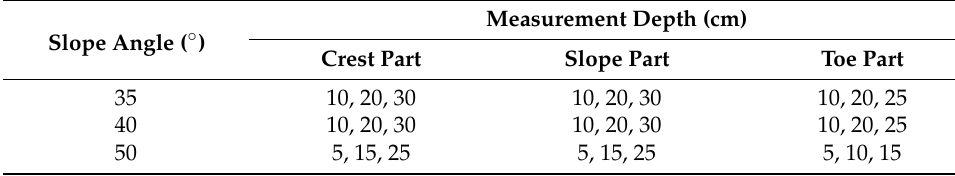
Table 2. Measurement depths at different slope